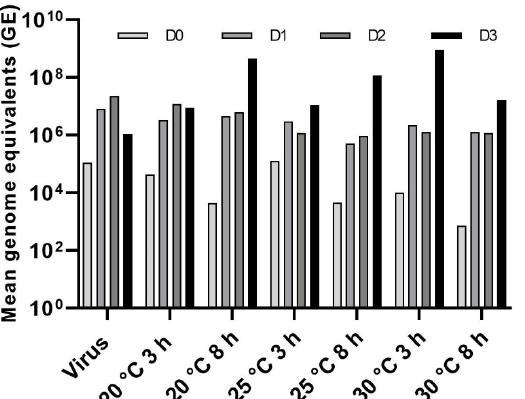
Figure 8. Absolute quantification of LJV following temperature pre ‐ treatment and oral delivery to adult Ds flies. The control (LJV without pre ‐ treatment) is shown on the x ‐ axis as “Virus” followed by the temperature pre ‐ treatment groups. The viral load was measured from day 0 to day 3 (D0– D3).